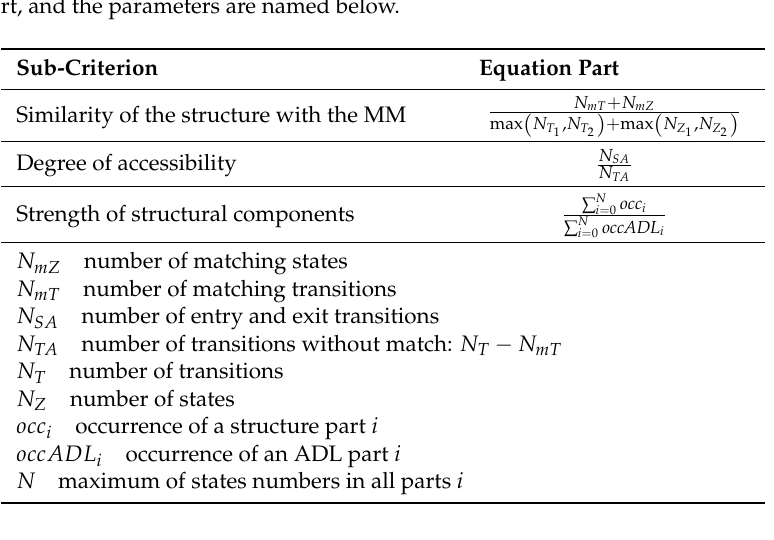
Table 1. Sub-criteria of the calculation for structural significance. Each sub-criterion is described by its equation part, and the parameters are named below.